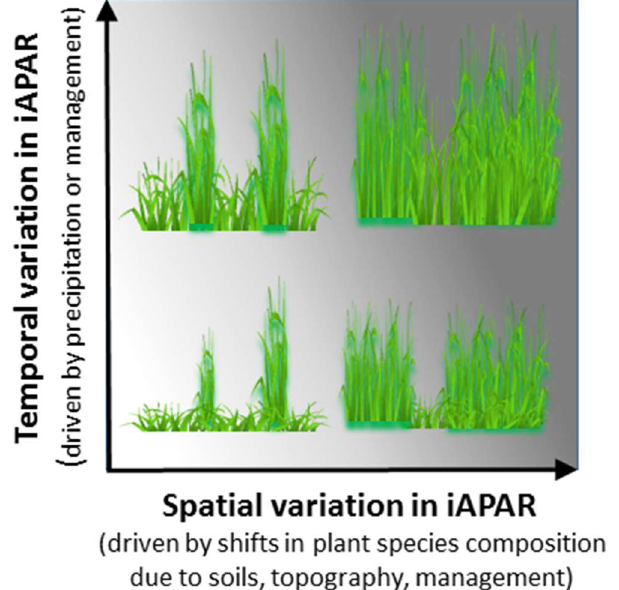
Figure 9. Conceptual model displaying the influence of space and time on iAPAR (represented by distance along the X and Y axes) and ANHP (represented by grey saturation within the figure). Temporal variation leads to shifts in both ANHP and iAPAR. However, spatial variation driven by changes in plant species composition and associated three-dimensional vegetation structure can lead to larger increases in ANHP per unit increase of iAPAR.